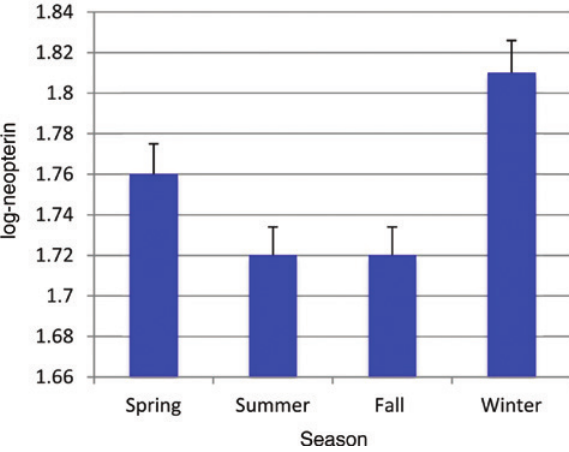
Figure 1: Seasonal variation in log-neopterin (mean and standard error). Y axis, log-neopterin concentrations